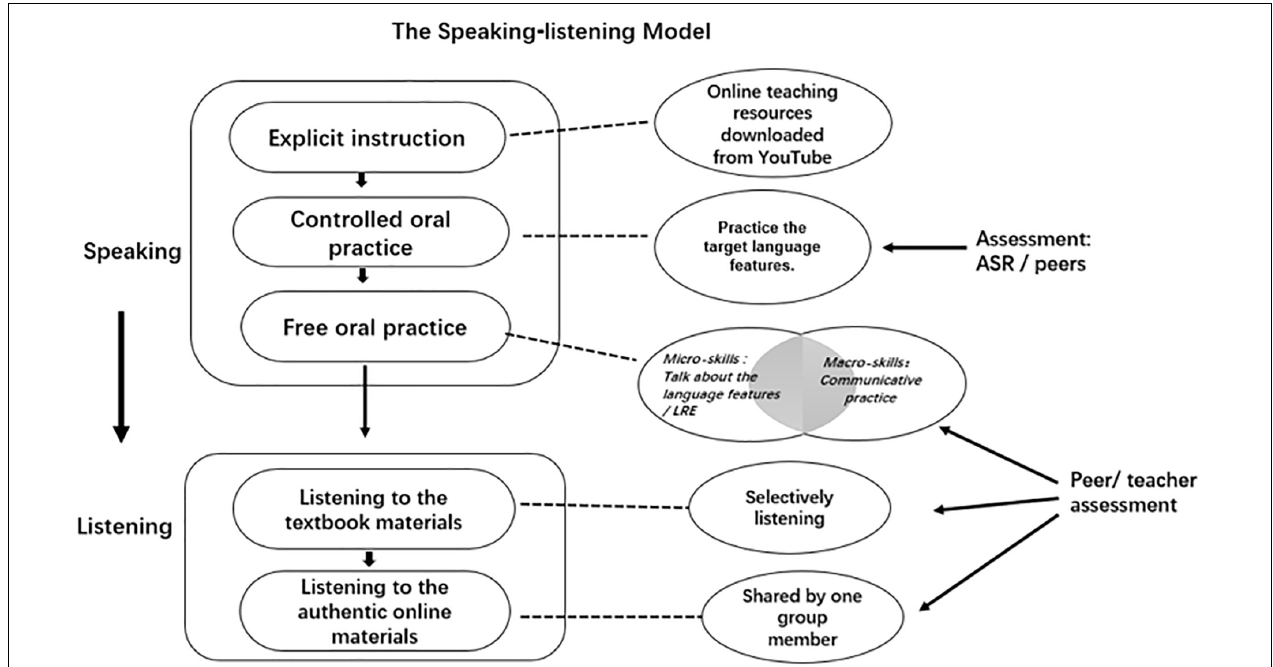
FIGURE 3 | Illustrations for the speaking-listening model.